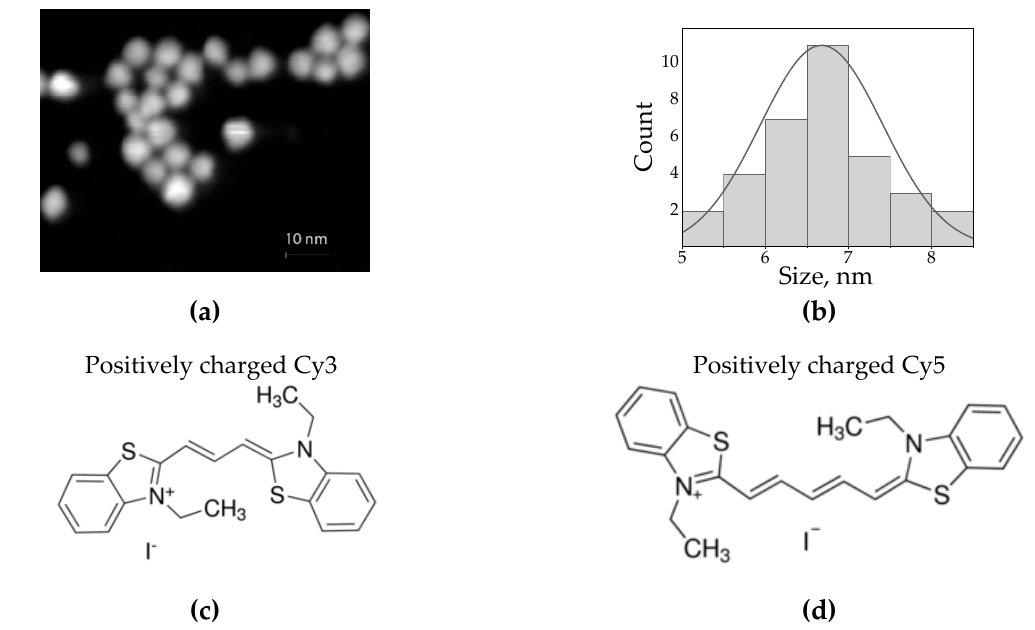
Figure 1. ( a ) Typical TEM image of synthesized water soluble AIS / ZnS quantum dots (QDs) with mean diameter of 6.7 nm; ( b ) histogram of the QDs size distribution; ( c , d ) are the structural formulas of the Cy3 and Cy5 molecules, respectively.